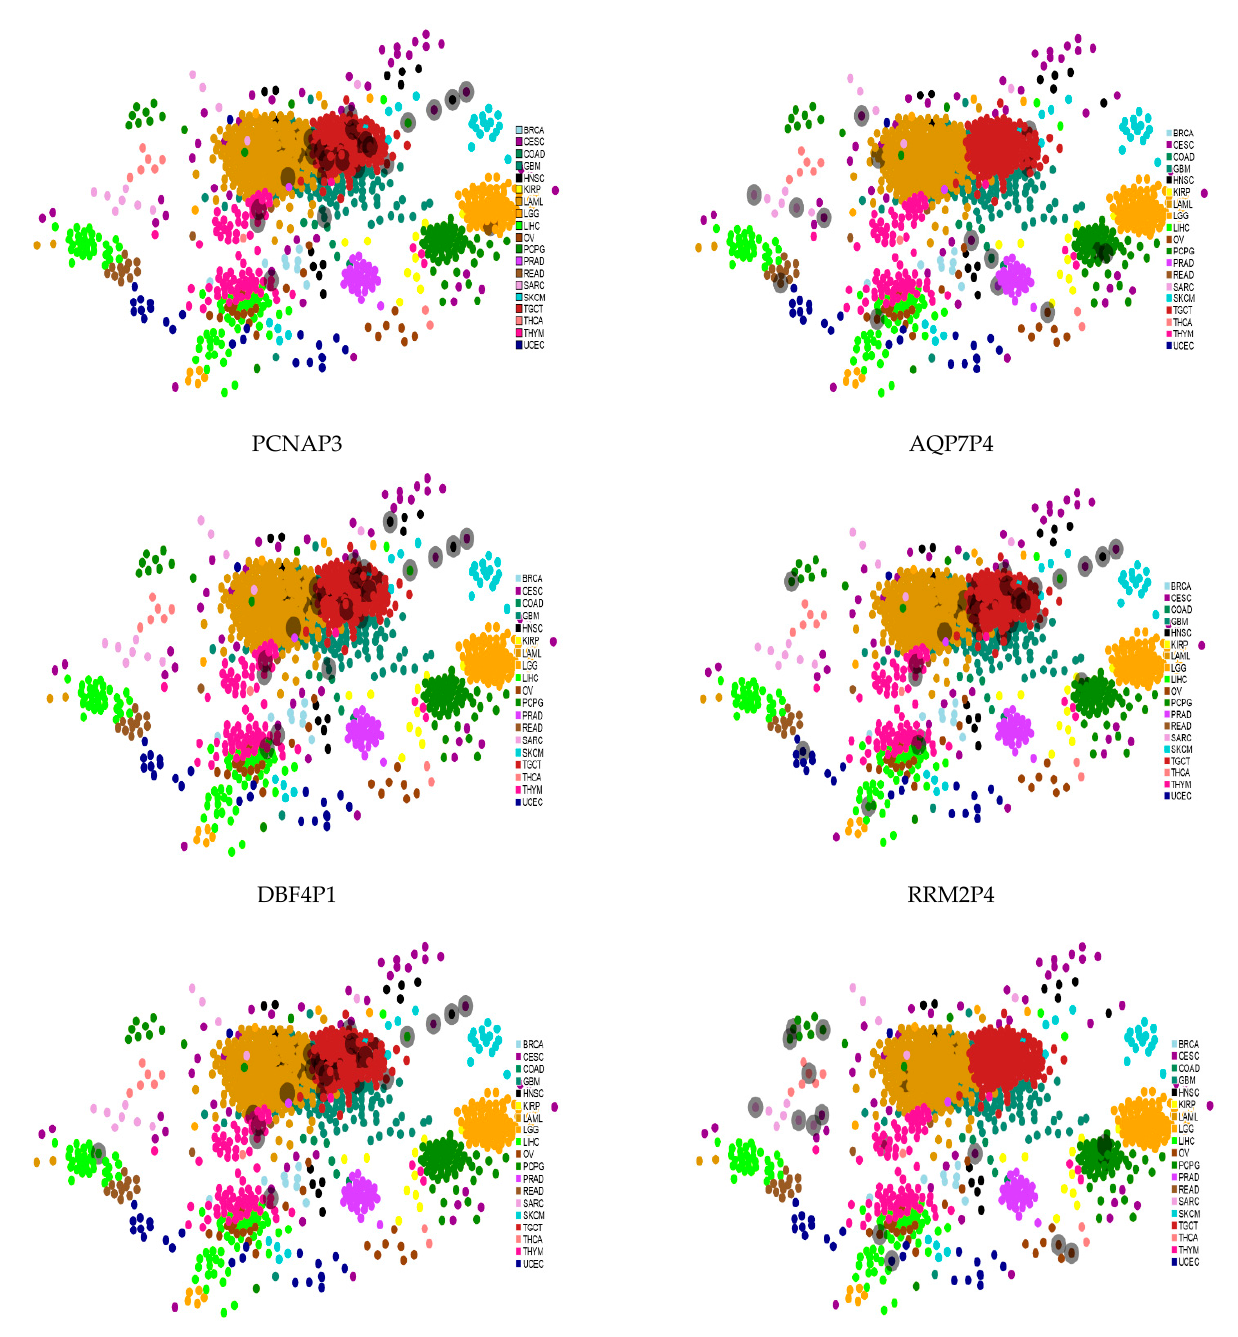
Figure 7. Examples of TF maps centered on basal ( left side) and luminal ( right side) selections. Source: ChEA3. Top 50 TF selected with integrated rank across libraries (ChIP-Seq with ENCODE, ReMap and Literature, co-occurrence with Enrichr, co-expression with GTEx and ARCHS4).